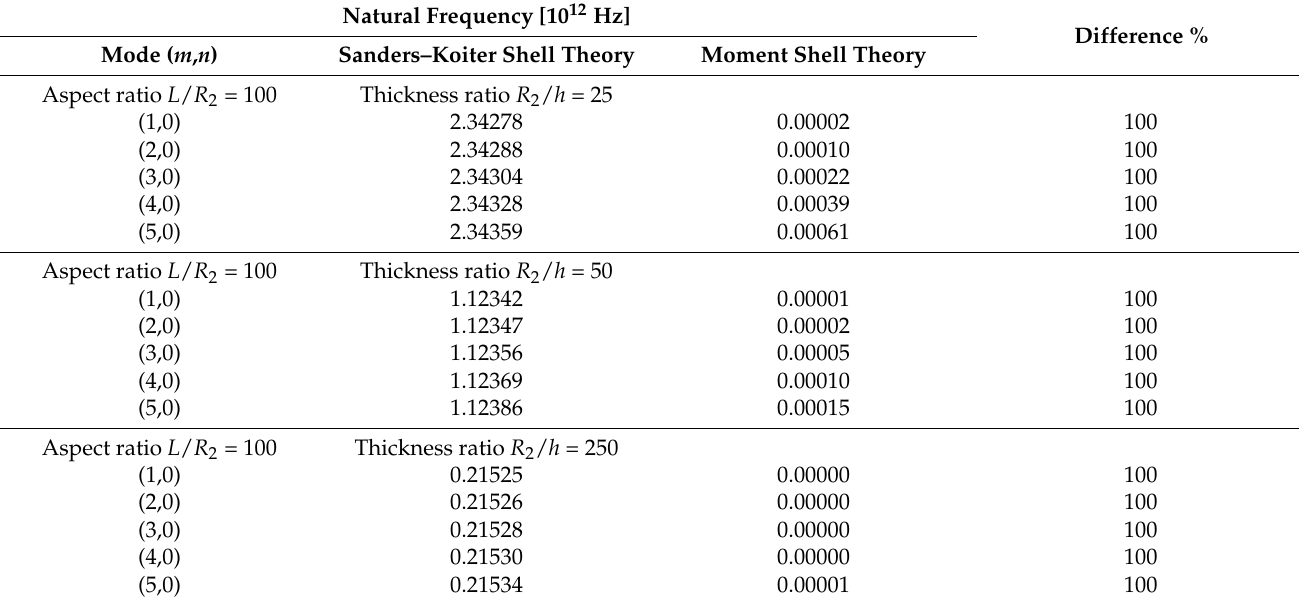
Table 8. Simply supported DWCNT with aspect ratio L / R 2 = 100 and thickness ratios R 2 / h = (25,50,250). Axisymmetric modes ( n = 0). Comparisons between Sanders–Koiter and moment shell